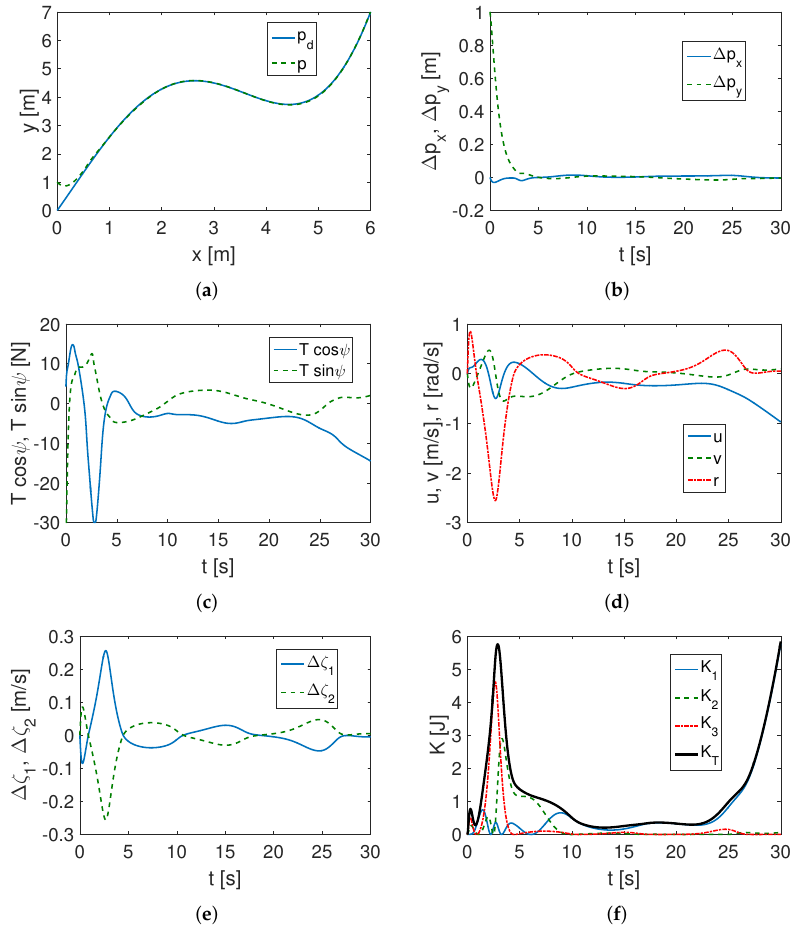
Figure 3. Simulation results for complex trajectory: ( a ) desired ( p d ) and realized ( p ) trajectory; ( b ) po- sition errors ∆ p x , ∆ p y (in inertial frame); ( c ) input signals components (applied force) T cos ψ , T sin ψ ; ( d ) actual velocities u , v , r ; ( e ) changes in quasi-velocity ( ∆ ζ 1 , ∆ ζ 2 ); ( f ) changes in kinetic energy ( K 1 , K 2 , K 3 , K T ) during